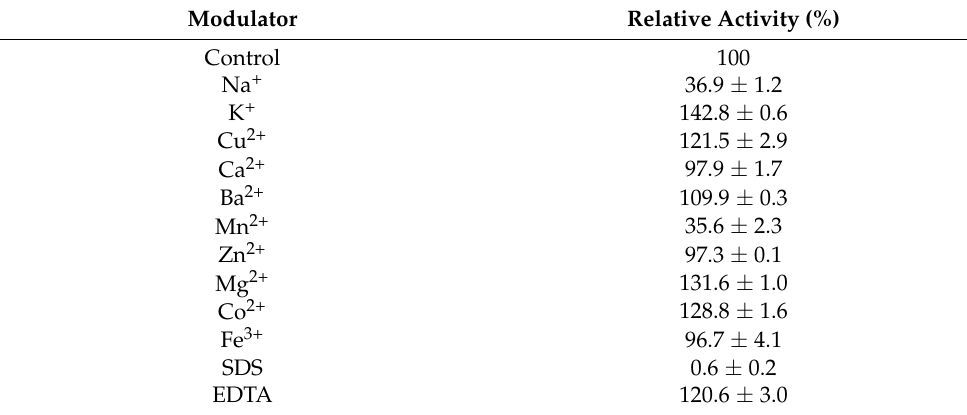
Table 4. The effect of various modulators on BsXyn10